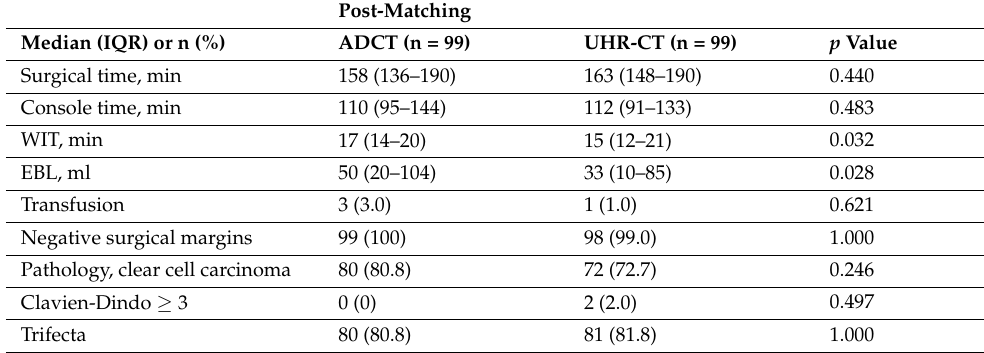
Table 2. Patients’ surgical outcomes.